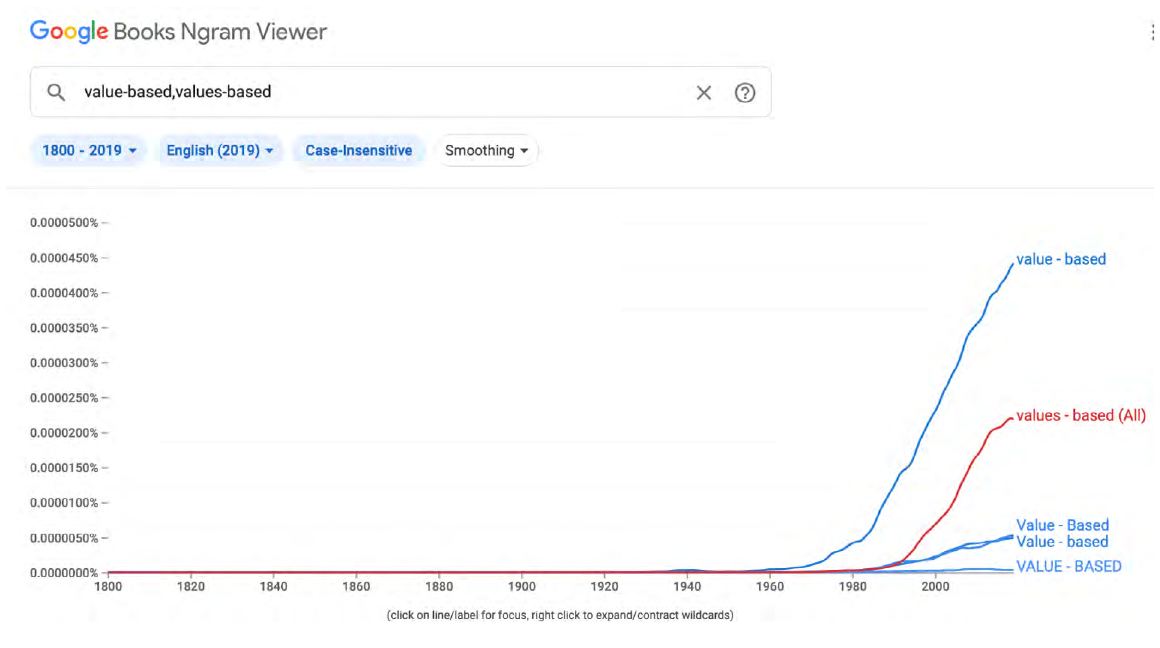
FIG. 1 A Google N-Gram search shows a rapid increase in use from the 1980s onward for the word ‘value-based’, and from the 1990s onward for ‘values-based’ (in the Google Books English language